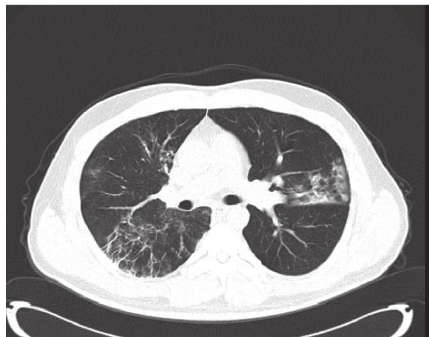
Figure 7: A middle age man after treatment and at 12 th day of symptoms onset with fibrotic changes.